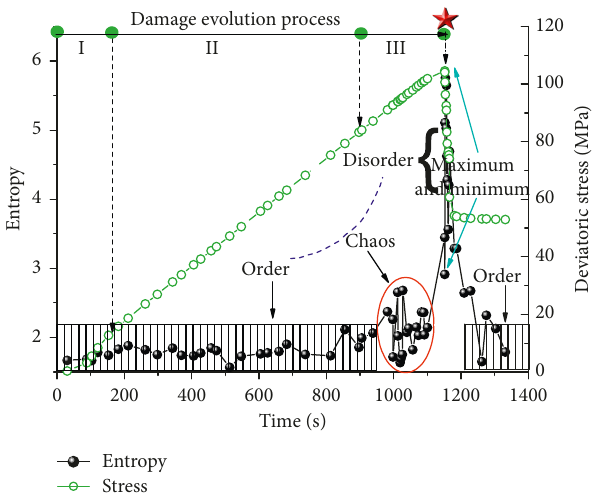
Figure 19: The variation law of sz-20 stress time entropy value.